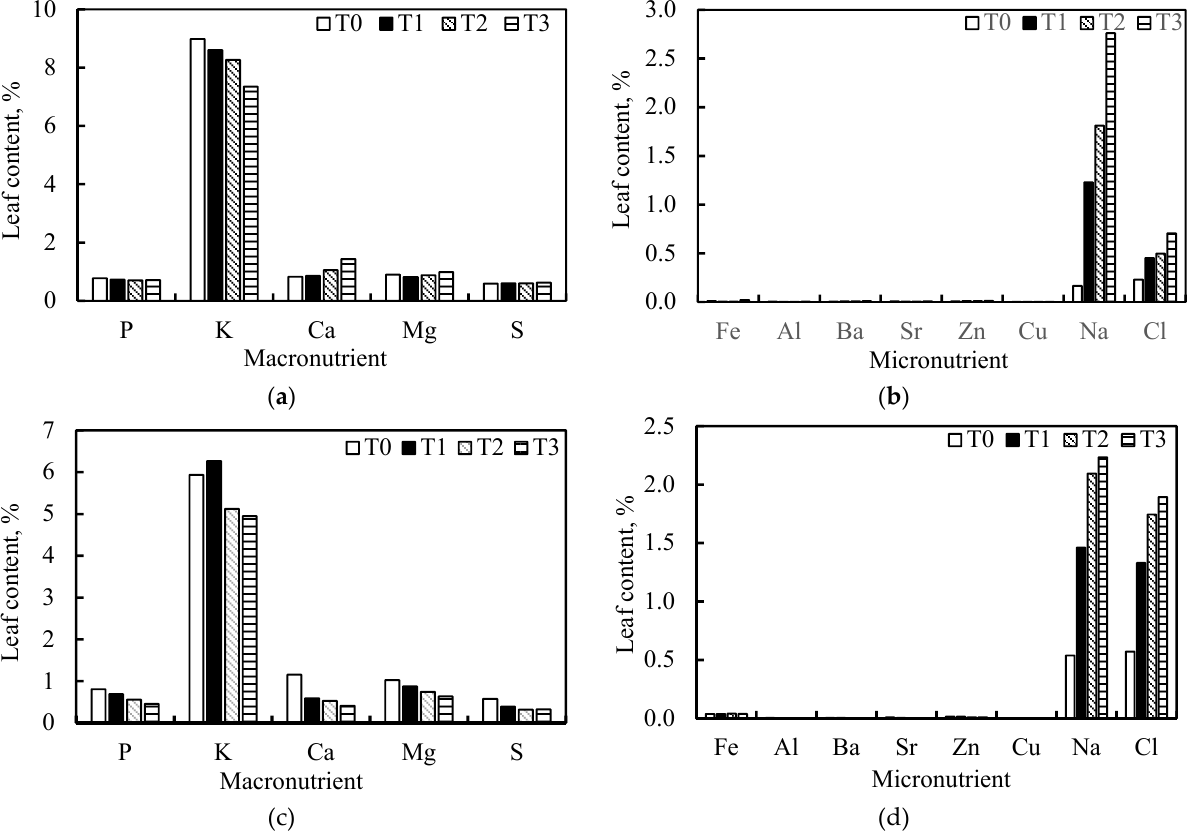
Figure 2. Macronutriment and micronutrient levels in leaves ( a , b first experiment; c , d second experiment). The salinity levels significantly affected the Na + and Cl − contents in all the treatments, but there were significant differences among the treatments. There was an increase in the sodium content in the leaves of P. oleracea at high-salt concentrations. Among the treatments, the highest Na + accumulation (2.76%) occurred in the treatment with the highest salinity level (T3). At this high-salinity level, the leaf chloride (Cl − ) content was significantly lower than the Na + content. The contents of the micronutrients Fe, Al, Ba, Sr, Zn, and Cu in the leaves were very low in all the treatments (Figure